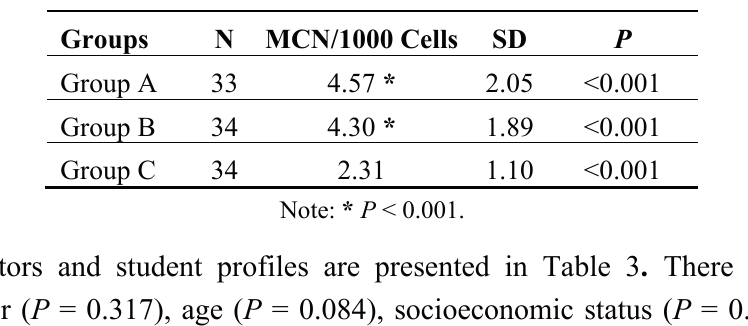
Figure 5. Positive association between NO